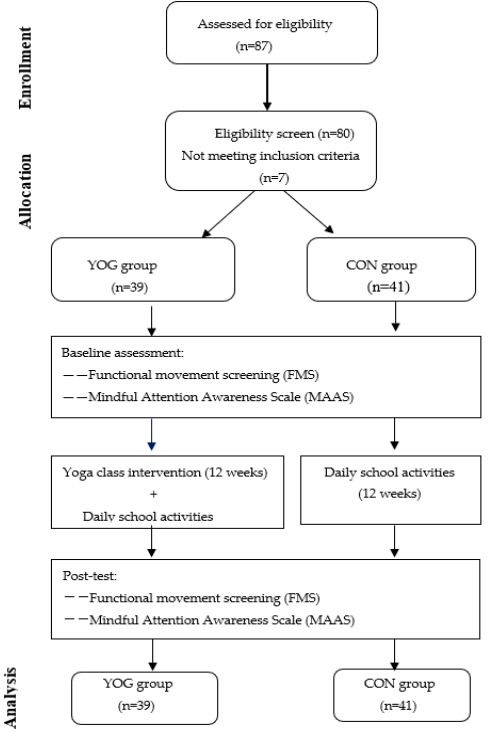
Figure 1. Study procedure. YOG group: yoga group; CON group: control group.